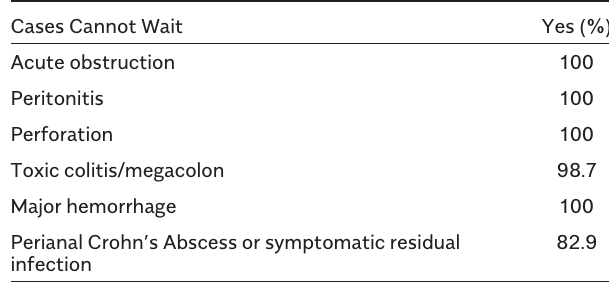
Table 6. Surgical Cases Which Cannot be Postponed due to COVID19 Pandemic